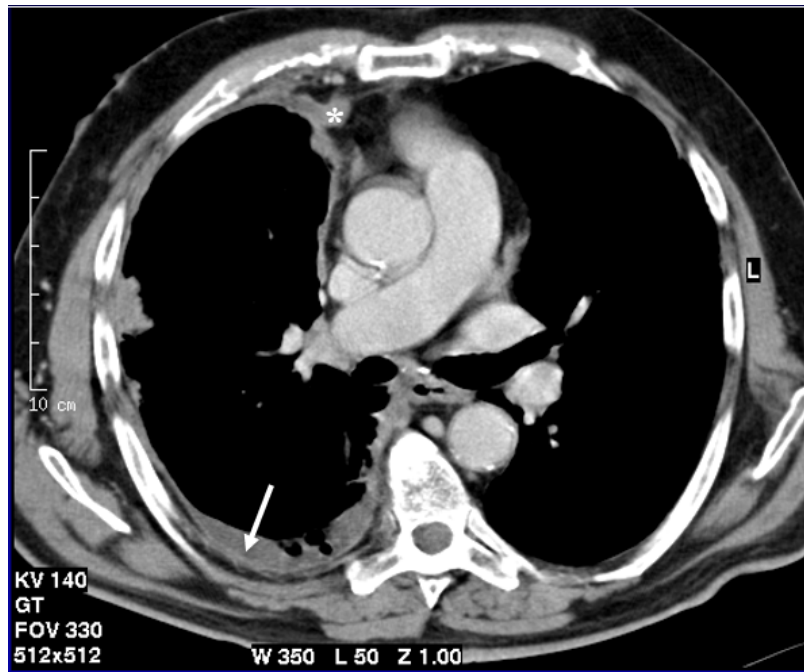
Figure 1. Axial CT scan after contrast administration reconstructed with smooth kernel with mediastinal windows demonstrates circumferential pleural nodular thickening with mediastinal pleura involvement (asterisk) and pleural effusion (arrow).